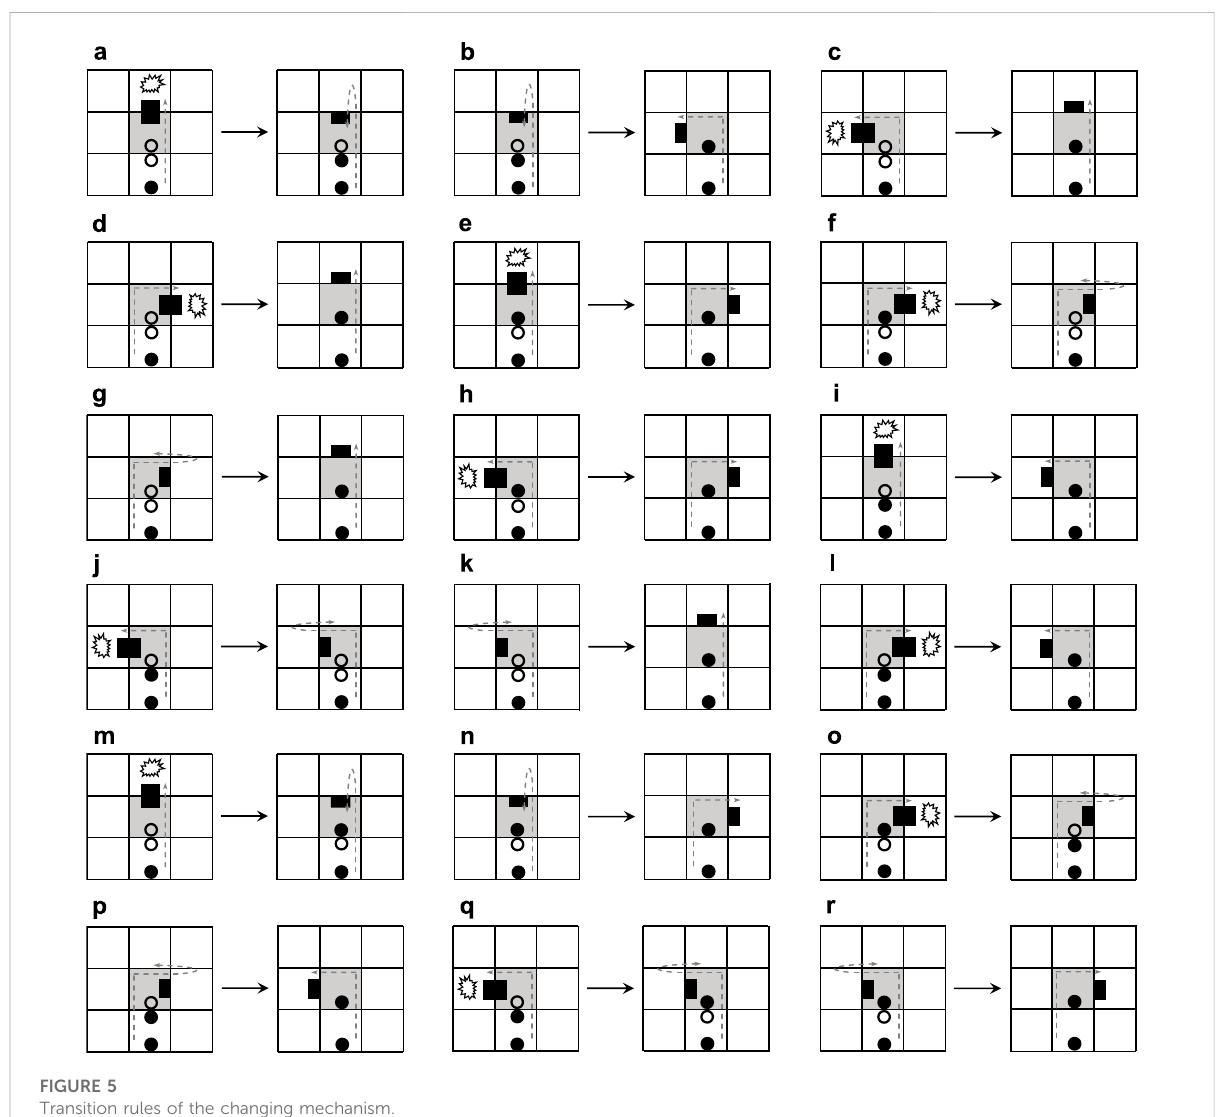
FIGURE 5 Transition rules of the changing